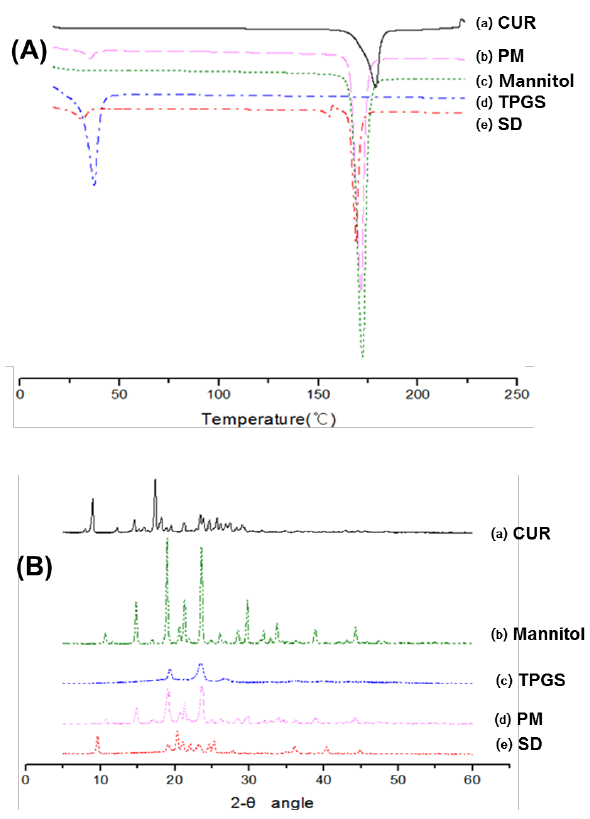
Figure 3. ( A ) Differential scanning calorimetry (DSC) thermograms of: (a) curcumin; (b) physical